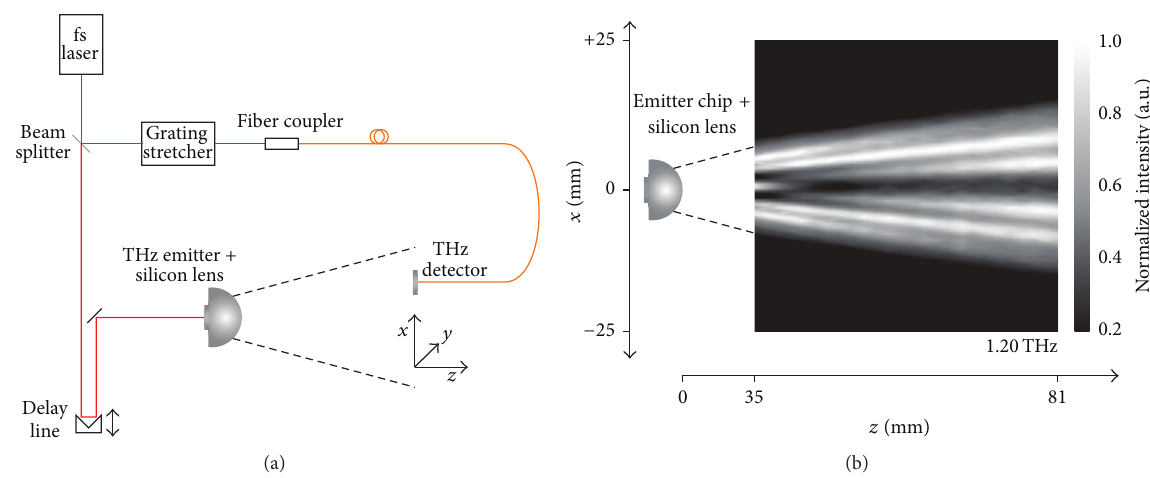
Figure 4: Schematic drawing of the setup for measuring radiation patterns (a). The fiber-coupled THz detector is movable in 𝑥 -, 𝑦 -, and 𝑧 -direction with stepper motors. At each position a TDS scan can be performed. The dimension of the active area of the detector antenna is considerably smallcompared to theTHzwavelength. An example of a measured beam profilein 𝑋𝑍 -plane isshown fora better understanding of the results (b).